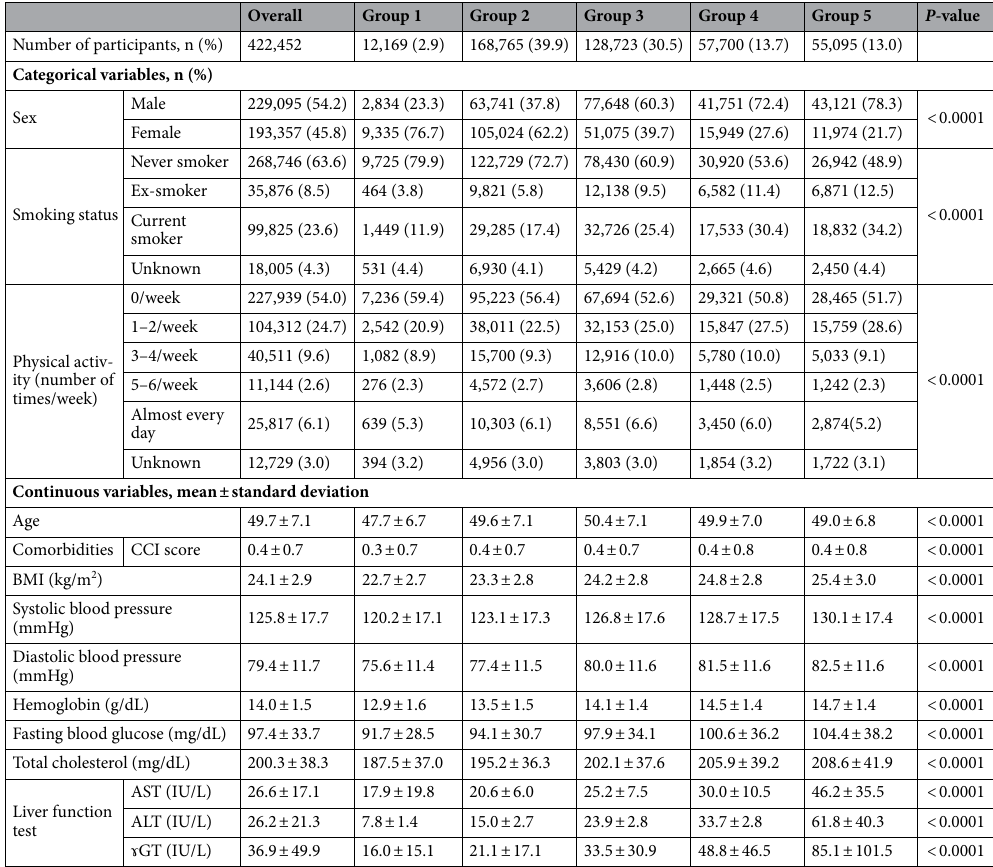
Table 1. Baseline characteristics of participants according to the serum ALT levels. ALT alanine aminotransferase, AST aspartate transaminase, BMI body mass index, CCI Charlson’s comorbidity index, ɤ GT gamma-glutamyl